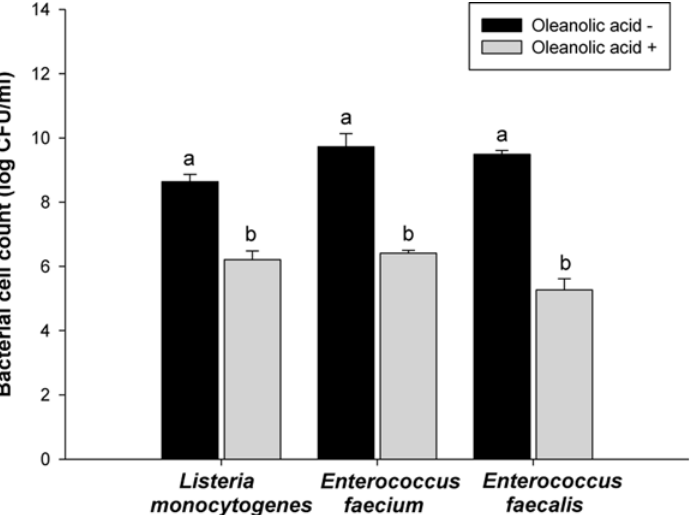
Fig 2. Bacterial cell viability. Listeria monocytogenes , Enterococcus faecium , and Enterococcus faecalis exposed to oleanolic acid at 2 × MIC. Viabilities of oleanolic acid-treated cells were compared with one of oleanolic acid-untreated cells. a-b: means with different letters are significantly different ( P < 0.05).